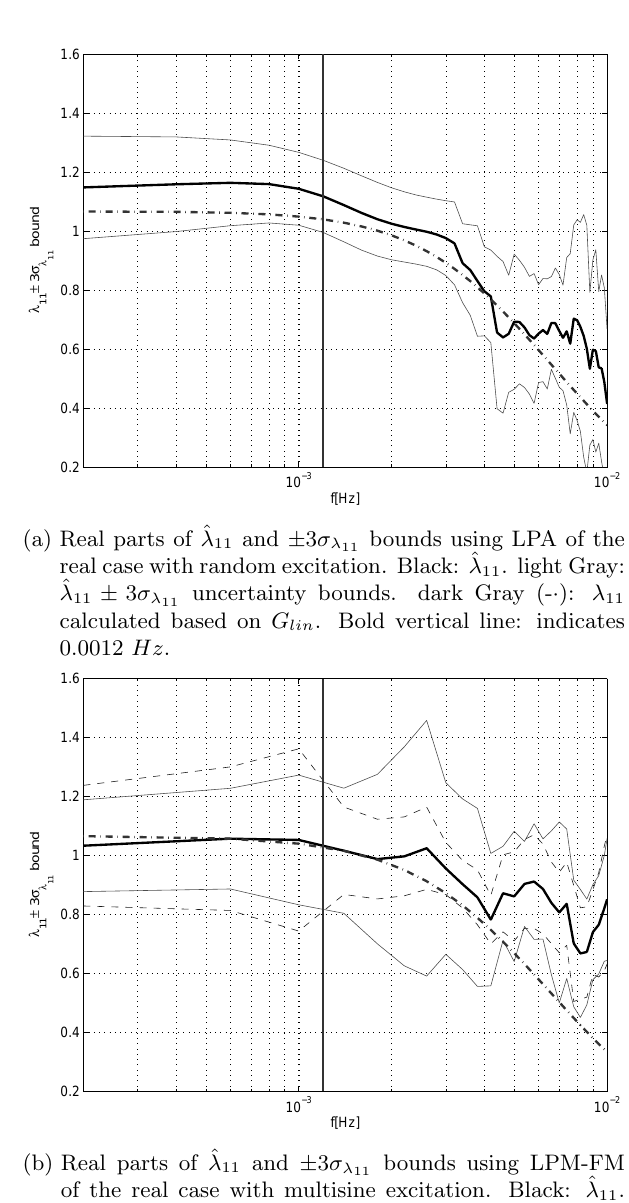
Figure 9: Real life results using LPA and LPA-FM